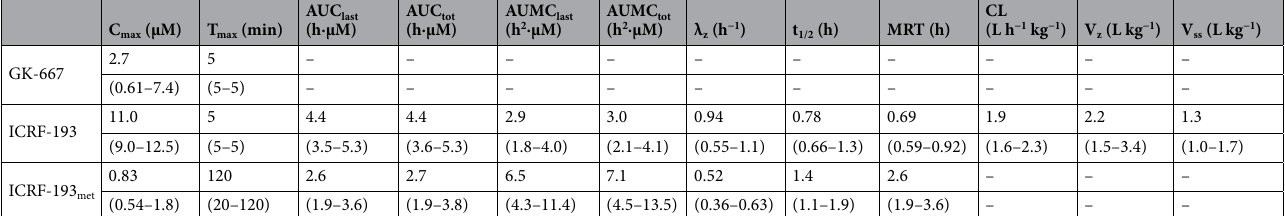
Table 1. Summary of pharmacokinetic parameters of GK-667, ICRF-193 and ICRF-193 met in rabbits determined by non-compartmental analysis. C max observed maximum plasma concentration, T max time to reach maximum plasma concentration, AUC last area under the concentration-time curve from zero up to the last quantifiable concentration, AUC tot area under the concentration-time curve from zero up to ∞ with extrapolation of the terminal phase, AUMC last area under the first moment of the concentration-time curve from zero to the last quantifiable concentration, AUMC area under the first moment of the concentration-time curve from zero up to ∞ with extrapolation of the terminal phase, λ z terminal rate constant of elimination, t 1/2 terminal half-life, MRT mean residence time, CL total clearance, V z apparent volume of distribution during terminal phase of elimination, V ss apparent volume of distribution at